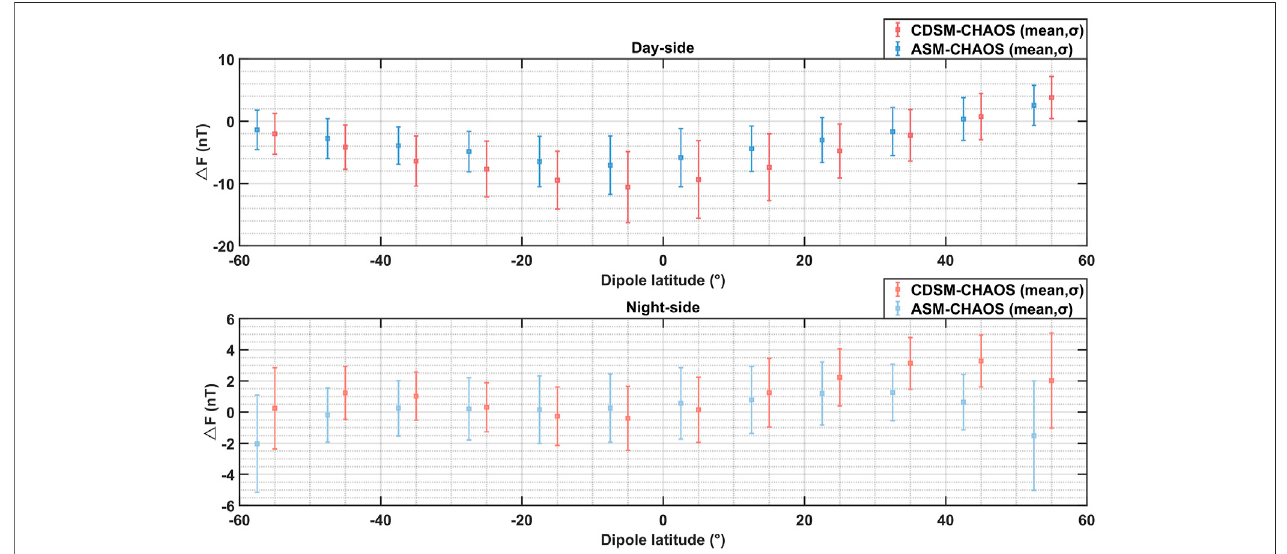
FIGURE11 | Error bars of Δ F of theCDSM and ASM using selected data from August 25 to29 September 2019(the error bars ofSwarm Alpha have been shifted 2.5 ° horizontally to the left in order to allow a visual comparison).